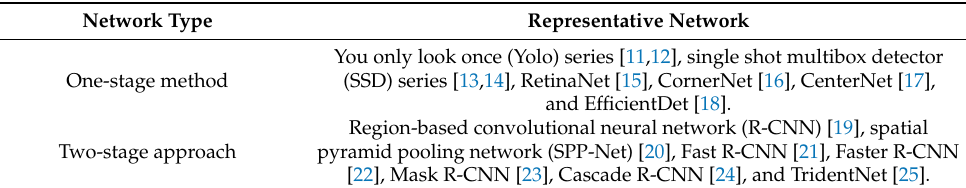
Table 1. The representative methods of deep learning network for target detection. Network Type